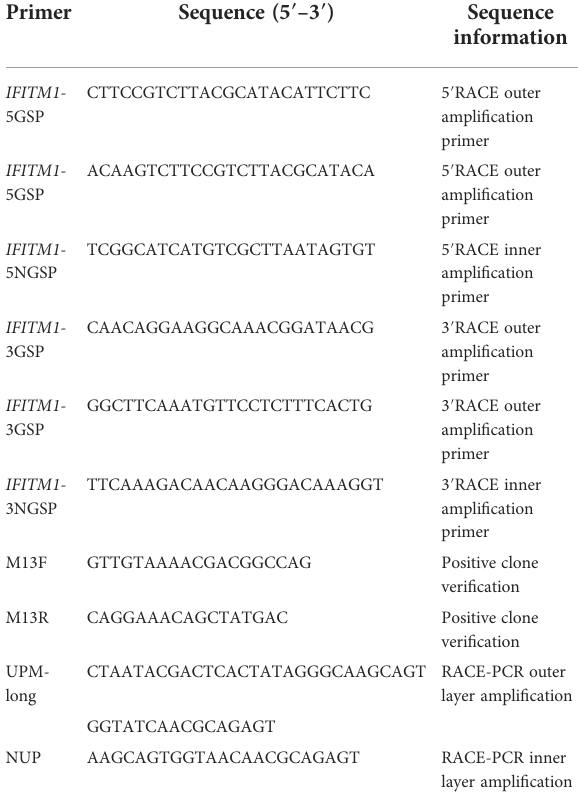
TABLE 1 Primers used for the cloning of IFITM1 in Cyclina sinensis